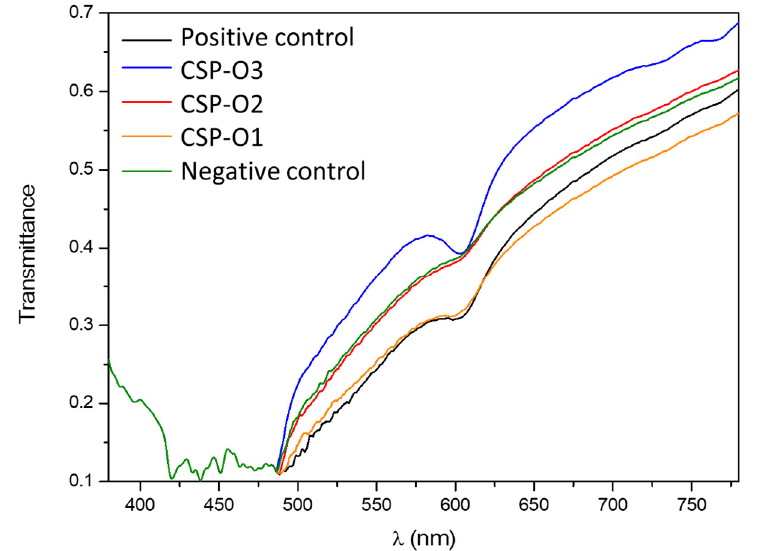
Figure 11. Transmittance profile from 400 to 800 nm wavelength of corneas treated for 10 min with ethanol as positive control, physiological saline solution as negative control, CSP-O1; CSP-O2; and CSP-O3.